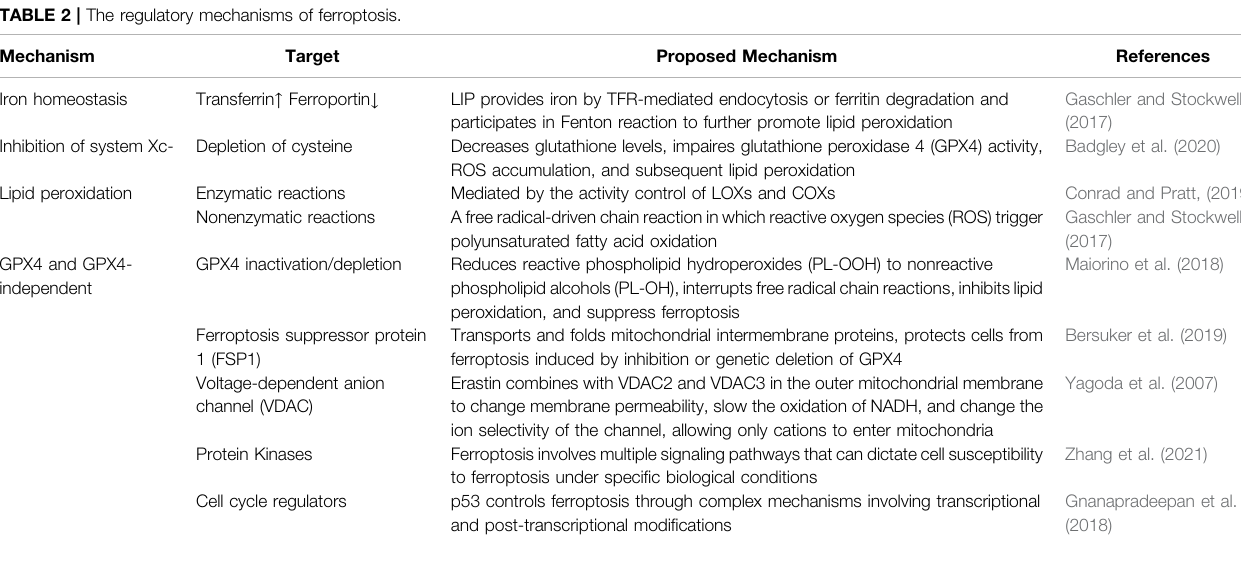
TABLE 2 | The regulatory mechanisms of